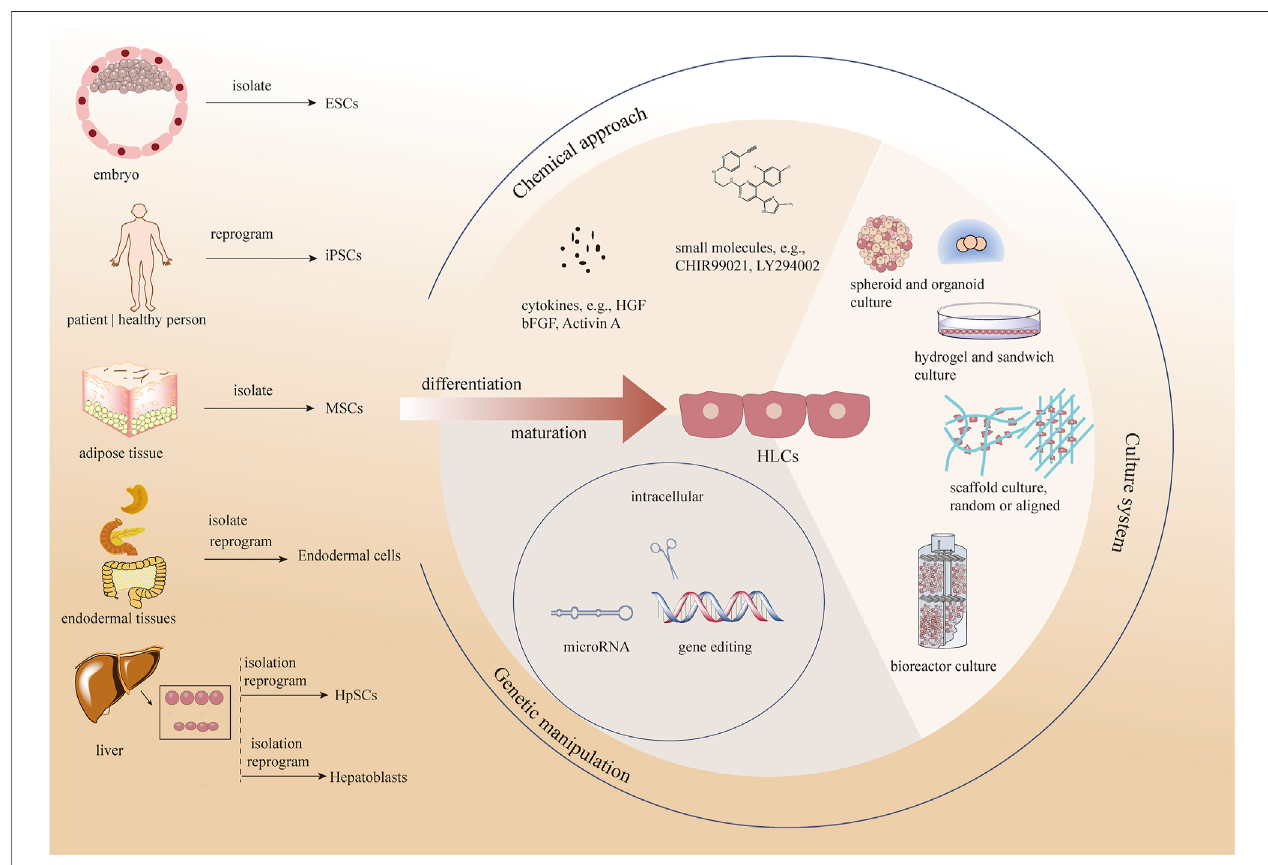
FIGURE 1 | Different methods promoting the maturation of HLCs in vitro as well as various cell sources for HLCs formation. ESCs, embryonic stem cells; iPCSs, included pluripotent stem cells, MSCs, Mesenchymal stem cells; HpSCs, hepatic stem cells; HGF, hepatocyte growth factor; bFGF, basic- fi broblast growth factor.